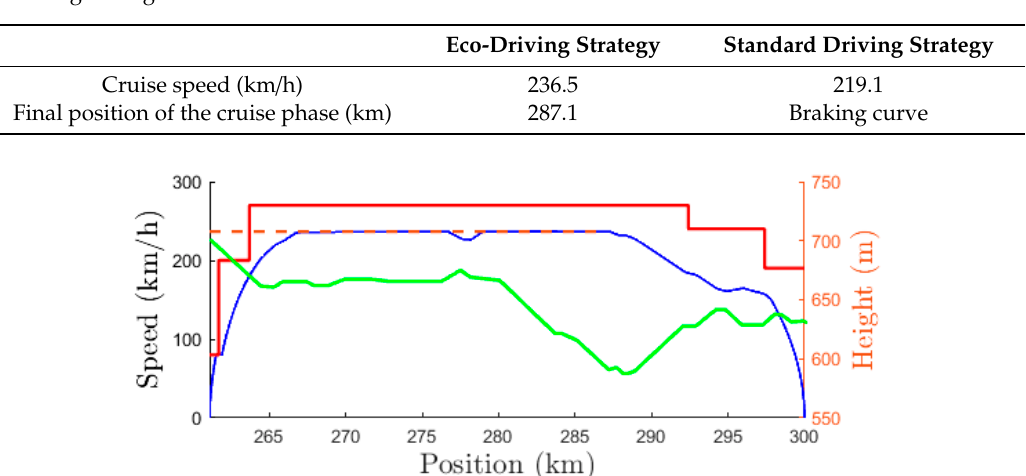
Table 4. Command vectors for the commercial time speed profiles obtained with the two considered driving strategies for the Puertollano–Ciudad Real section.